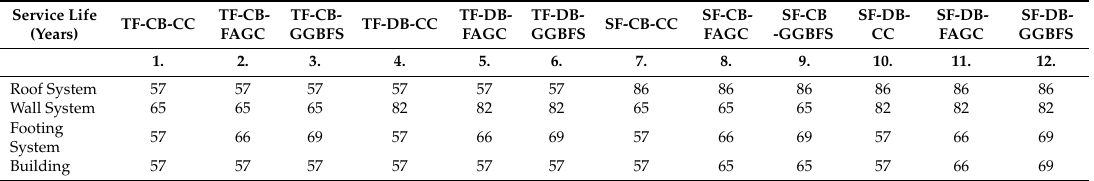
Table 5. Estimated service life of building systems and